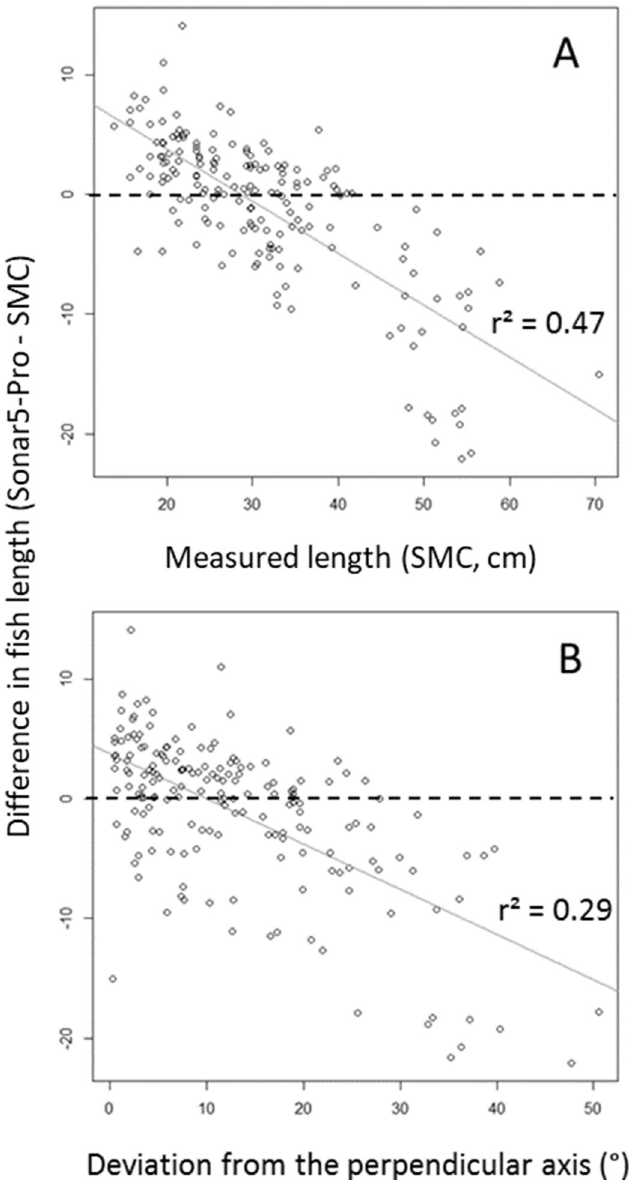
Fig. 6. Evaluation of the accuracy of the Sonar5-Pro exported length as a function of (A) measured fi sh length (cm), and (B) fi sh body angle (degrees) ( n = 179). Line represents linear